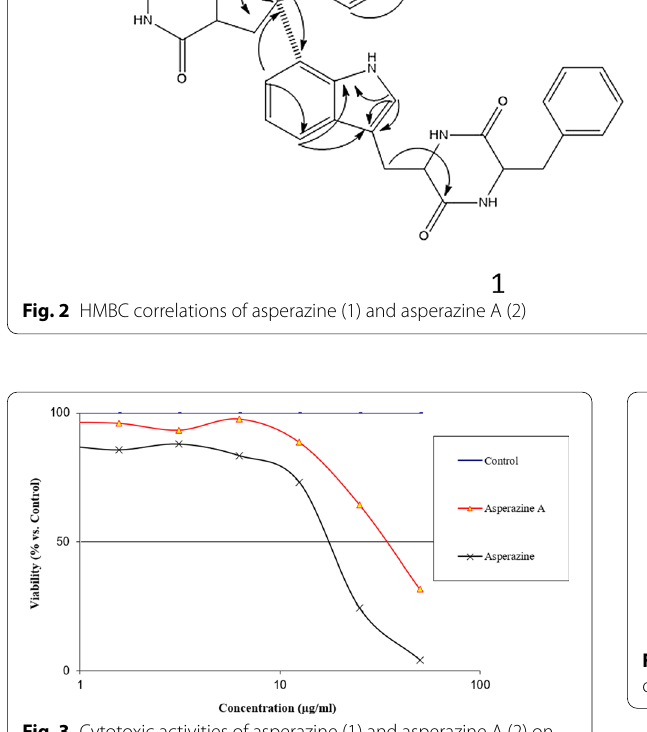
Fig. 3 Cytotoxic activities of asperazine (1) and asperazine A (2) on HeLa